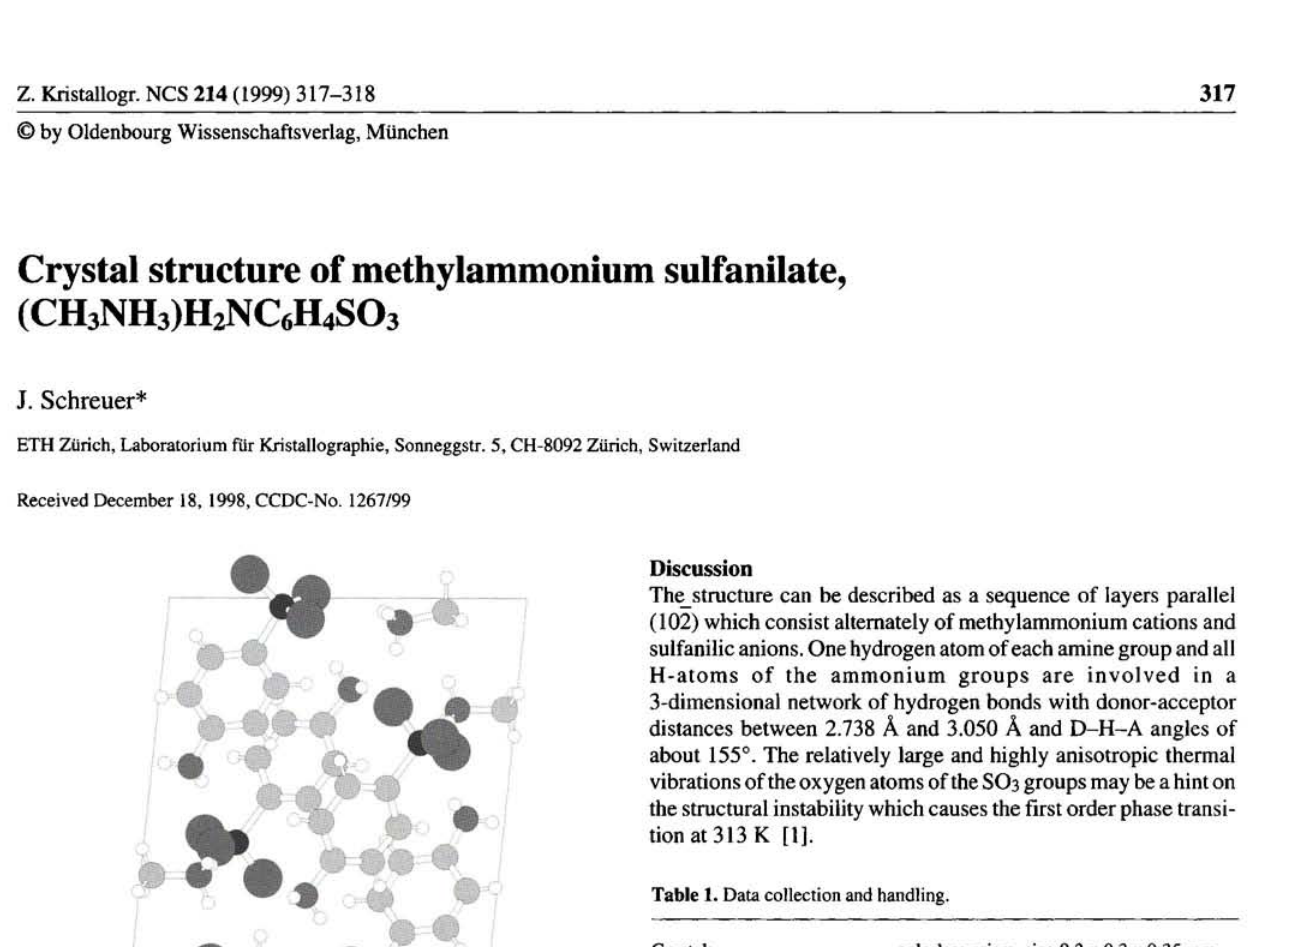
Table 2. Atomic coordinates and displacement parameters (in Â 2